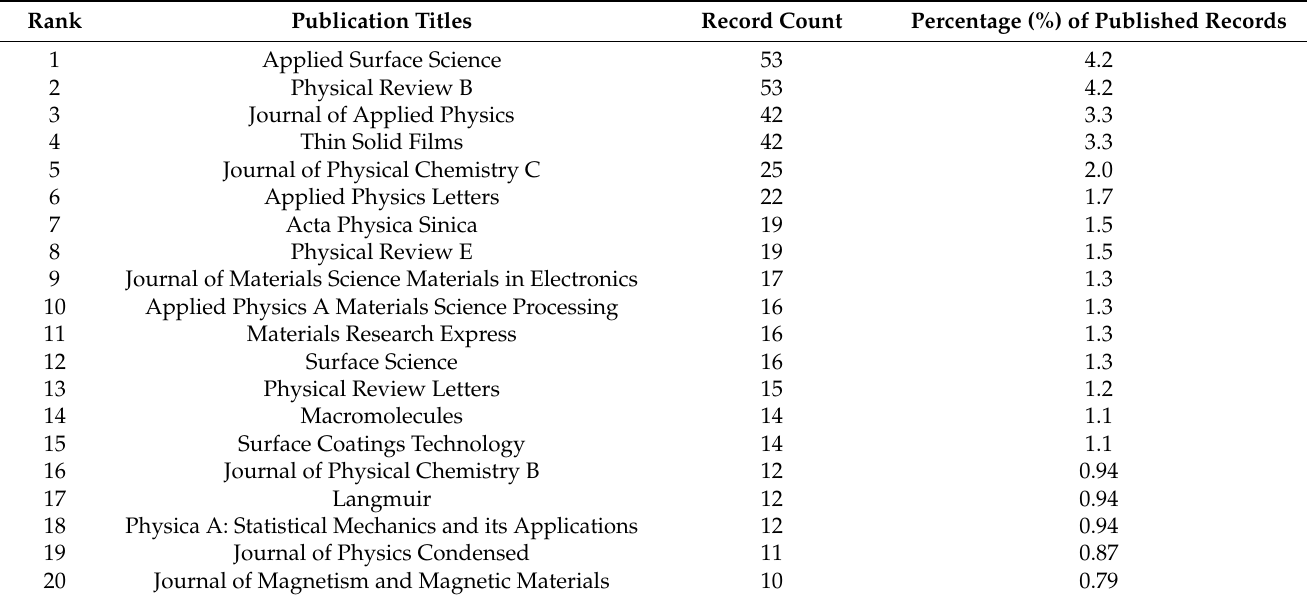
Table 2. Top 20 leading journals in research on fractal theory in thin film technologies and materials according to Web of Science database.